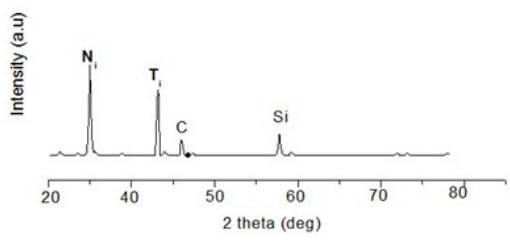
Figure 5. XRD analysis of the sintered